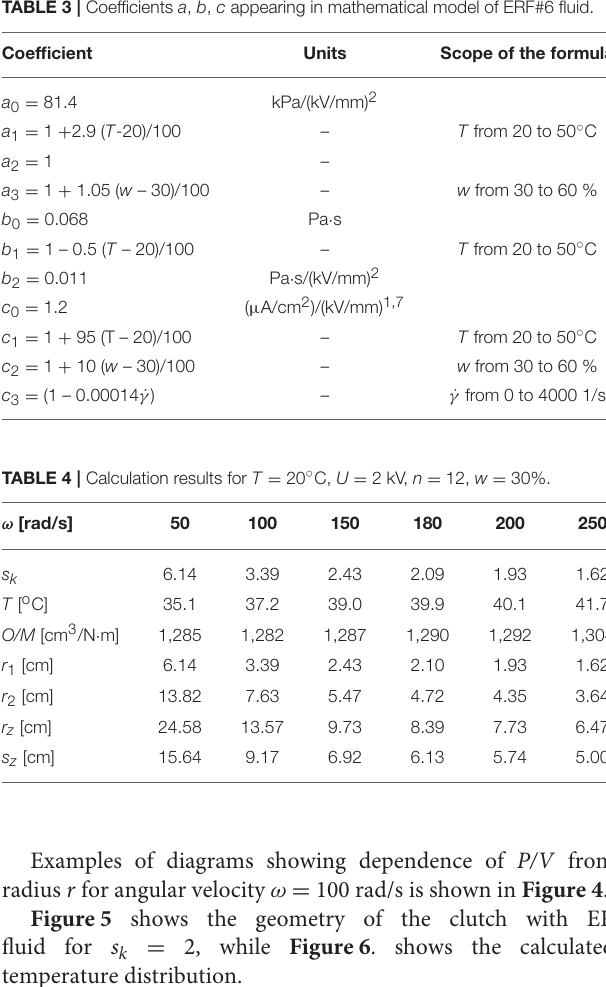
TABLE 3 | Coefficients a , b , c appearing in mathematical model of ERF#6 fluid.